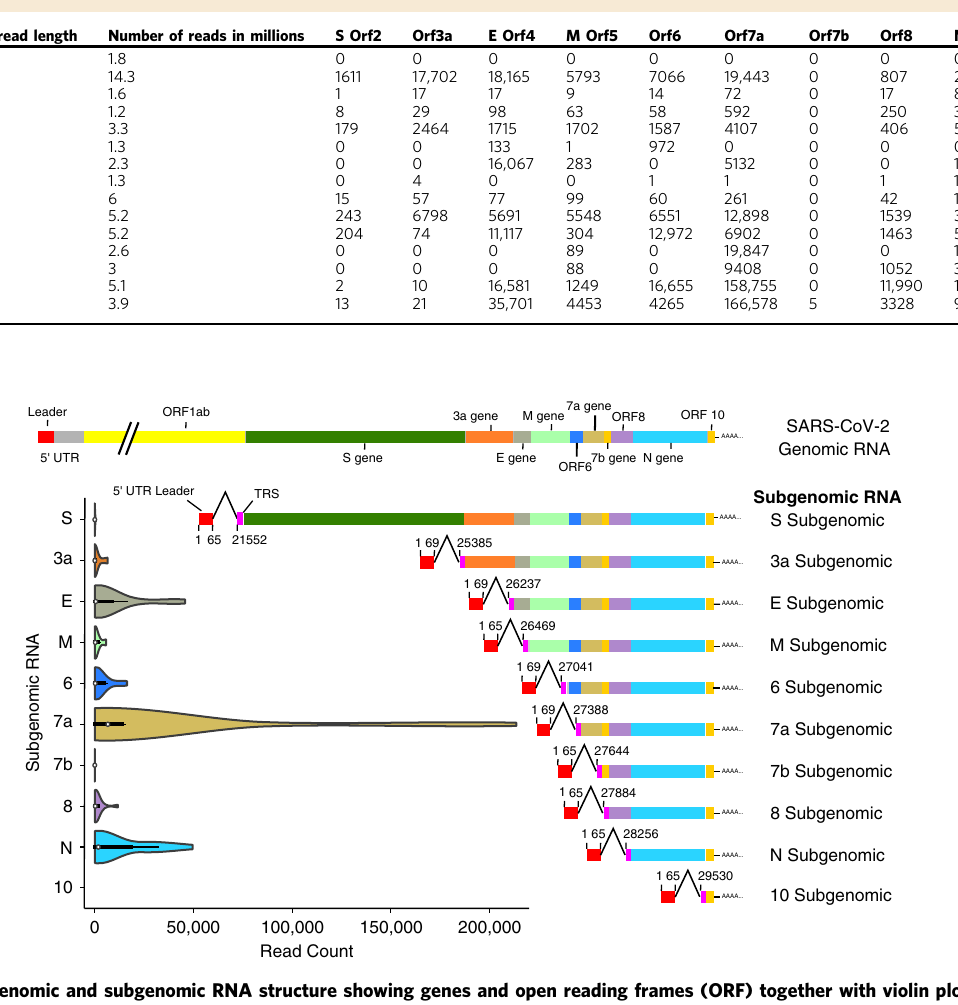
Table 2 Table showing the details of the sample number, average read length, number of reads and number of reads mapped to each subgenomic SARS-CoV-2 RNA.